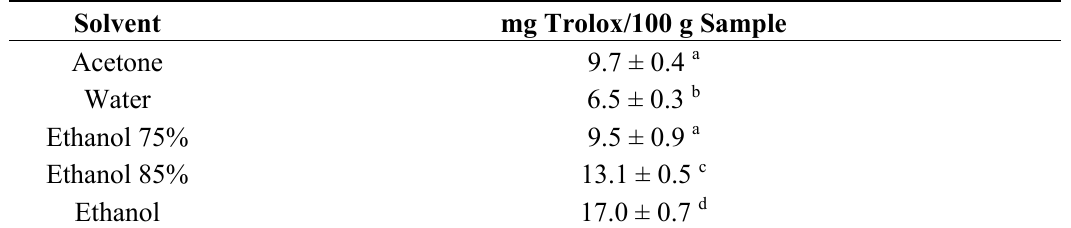
Table 3. Comparison of antioxidant activity contents in onions above different extraction